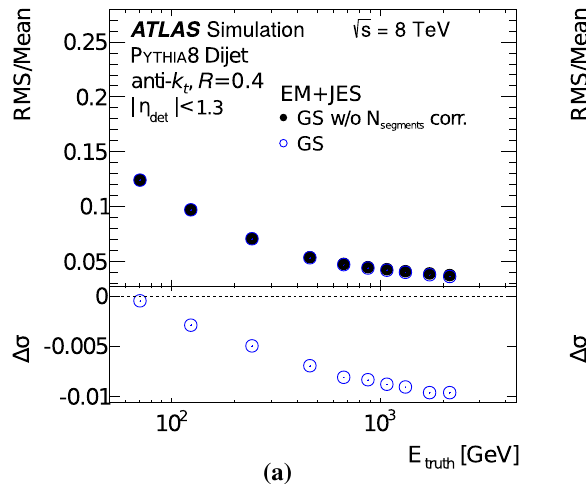
selects a large fraction of “uncontained” jets, i.e. jets for which some of the particles produced in the hadronic shower travel into the muon spectrometers behind the calorimeters. The bottom panels show the improvement introduced by the corrections quantified using subtrac- tion in quadrature (Eq.